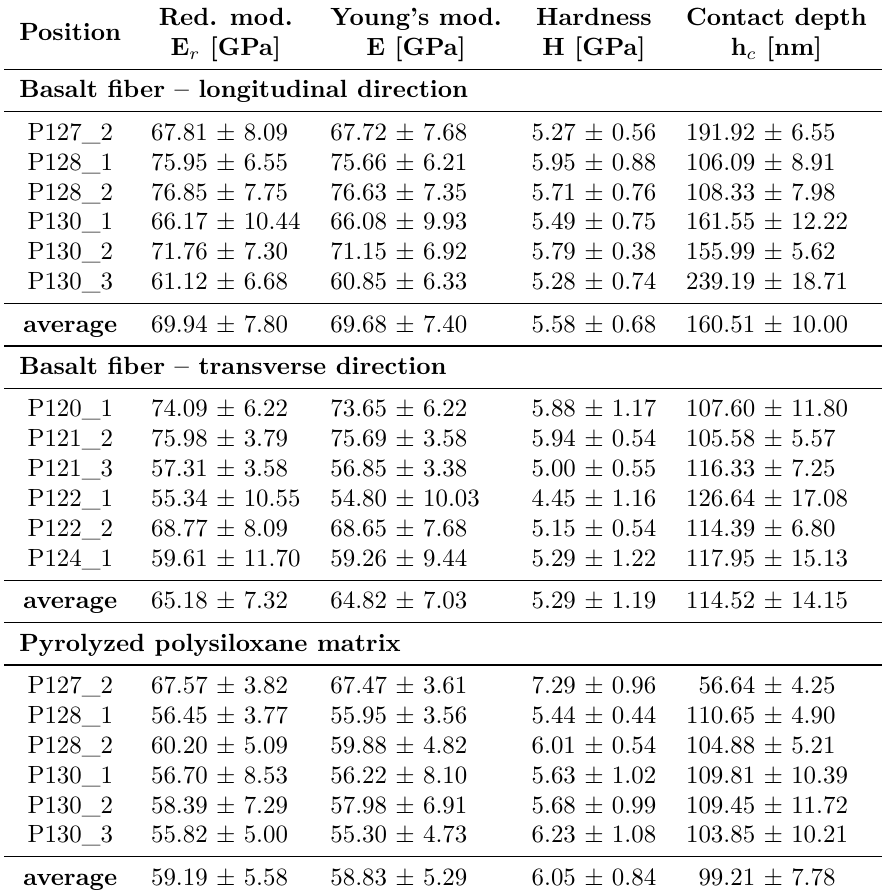
Table 1. Indentation results of individual material phases.